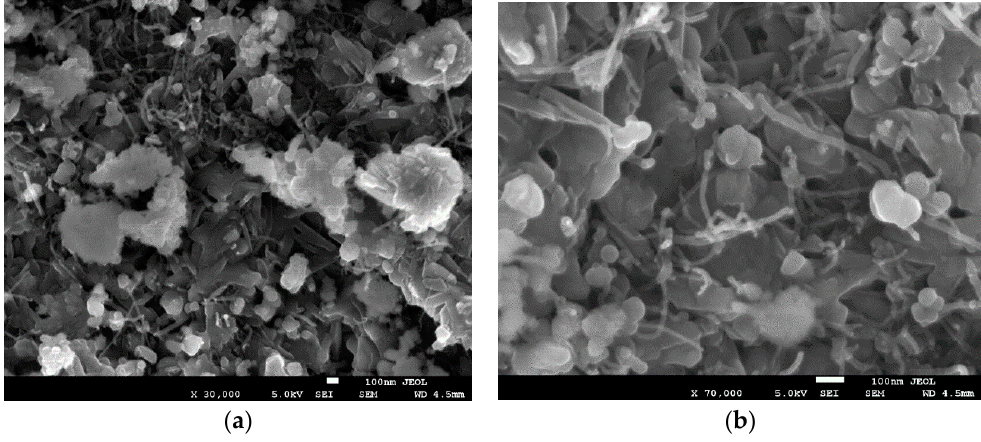
Figure 4. The unprocessed CNT ‐ doped MgB 2 sample after sintering. ( a ) Low magnification (30,000×); ( b ) High magnification (70,000×).